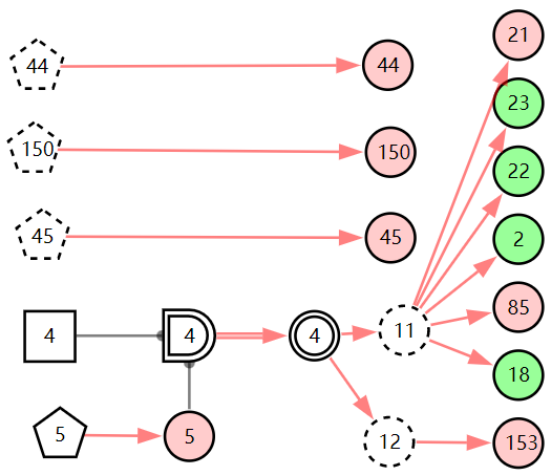
Figure 9. The graphic interpretation of acute laryngitis when E (cid:48) = X 7,4 X 52,1 X 85,1 X 21,1 X 15,1 X 45,1 X 44,1 X 150,1 X 5,1 X 153,1